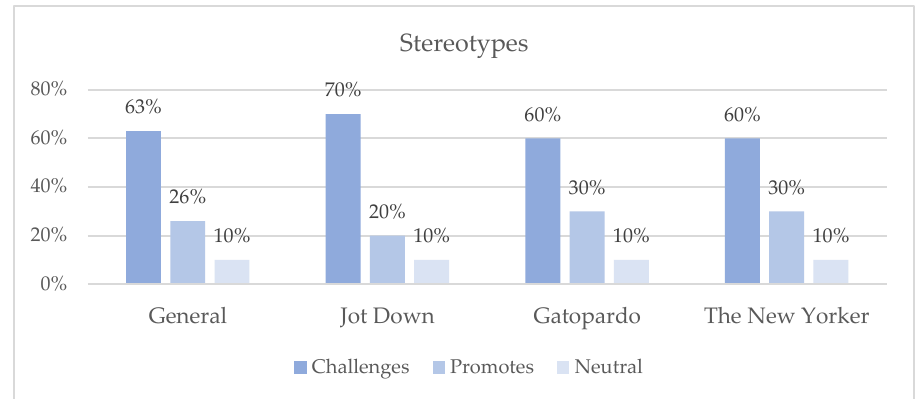
Figure 8. Analysis of the possible promotion or challenge of stereotypes about religions in the articles studied.